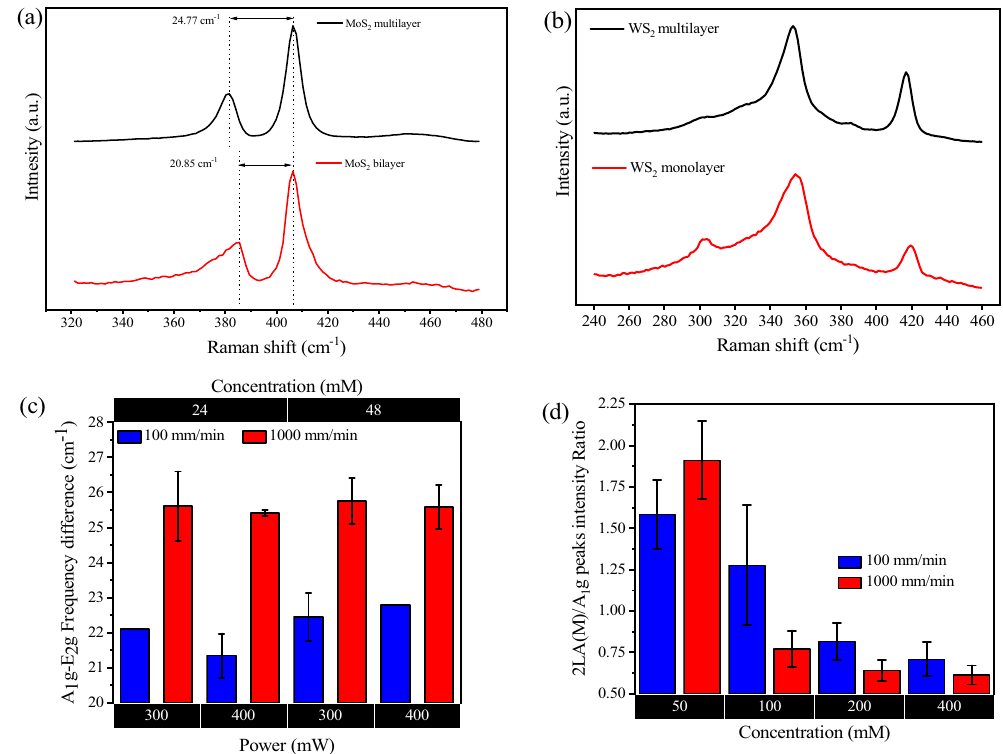
Figure 2. ( a ) Raman spectra corresponding to a laser synthesised bilayer (red curve) and multilayer (black curve) of MoS 2 . ( b ) Raman spectra of single layer (red curve) and multi-layer (black curve) of WS 2 . ( c ) Histogram showing the average Raman spectral separation (A 1 g-E 2 g) of MoS 2 as function of different laser writing conditions (10 × objective used for focusing the laser beam). The error bar represents the standard deviation for four individual MoS 2 tracks. ( d ) Graph represents the average of Raman peak intensity ratio 2LA (M) /A 1 g of WS 2 post-deconvolution as function of different laser writing conditions. The laser power was fixed to 300 mW and 20 × objective were used to focus the laser beam. The error bars represent the standard deviation from Raman spectra obtained on five individual WS 2